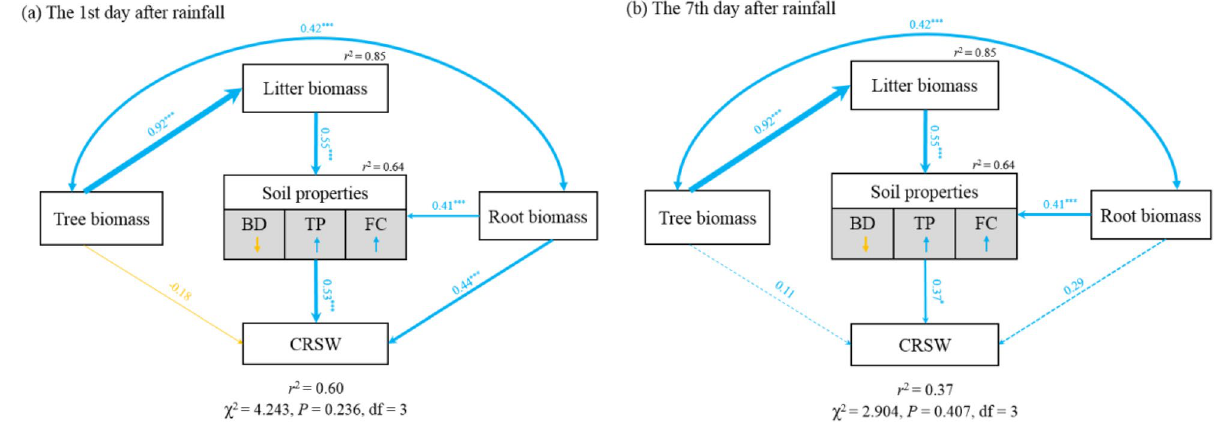
Figure 6. Structural equation model (SEM) showing the effects of soil properties, tree biomass root biomass and litter biomass on the CRSW (the contribution of heavy rainfall to soil water) on the first (a) and seventh (b) days after heavy rainfall (n = 60). Soil properties measured include BD (bulk density), TP (total porosity) and FC (field capacity). Arrows indicate effect directions and paths; red and blue lines represent positive and negative effects, respectively; line widths denote the strength of path coefficients. Standardized path coefficients shown on the lines represent the effect sizes of relationships. Goodness-of-fit statistics of the model are displayed below the model. ** P < 0.01, *** P < 0.001.